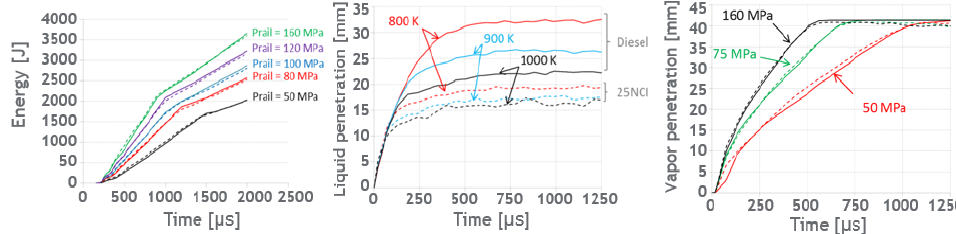
Figure 3. (Left ): Injected energy quantity versus energizing duration for different fuel injection pressures (MPa); ( Center ): liquid penetration for various air temperatures (air density 15 kg/m 3 ) at fuel injection pressure 160 MPa; ( Right ): vapor spray penetration for different fuel injection pressures and air temperature 900 K versus time — dual (solid lines) diesel – CN25 fuel (dashed lines) is a figure. Schemes follow the same formatting.